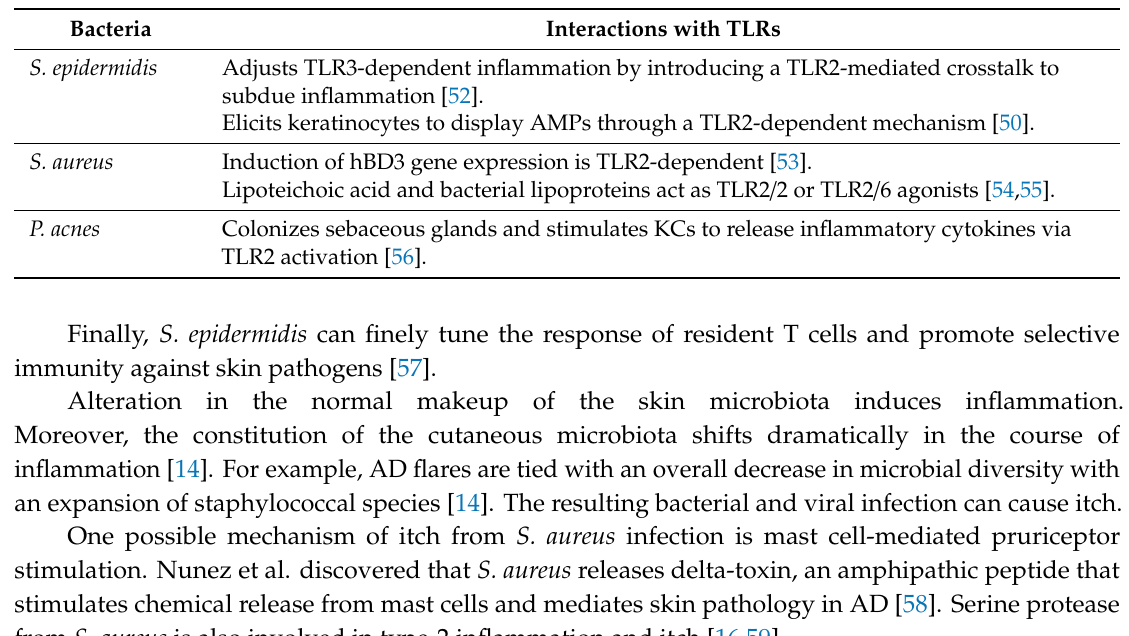
Table 1. Interaction between the skin microbiota and the Toll-like receptors